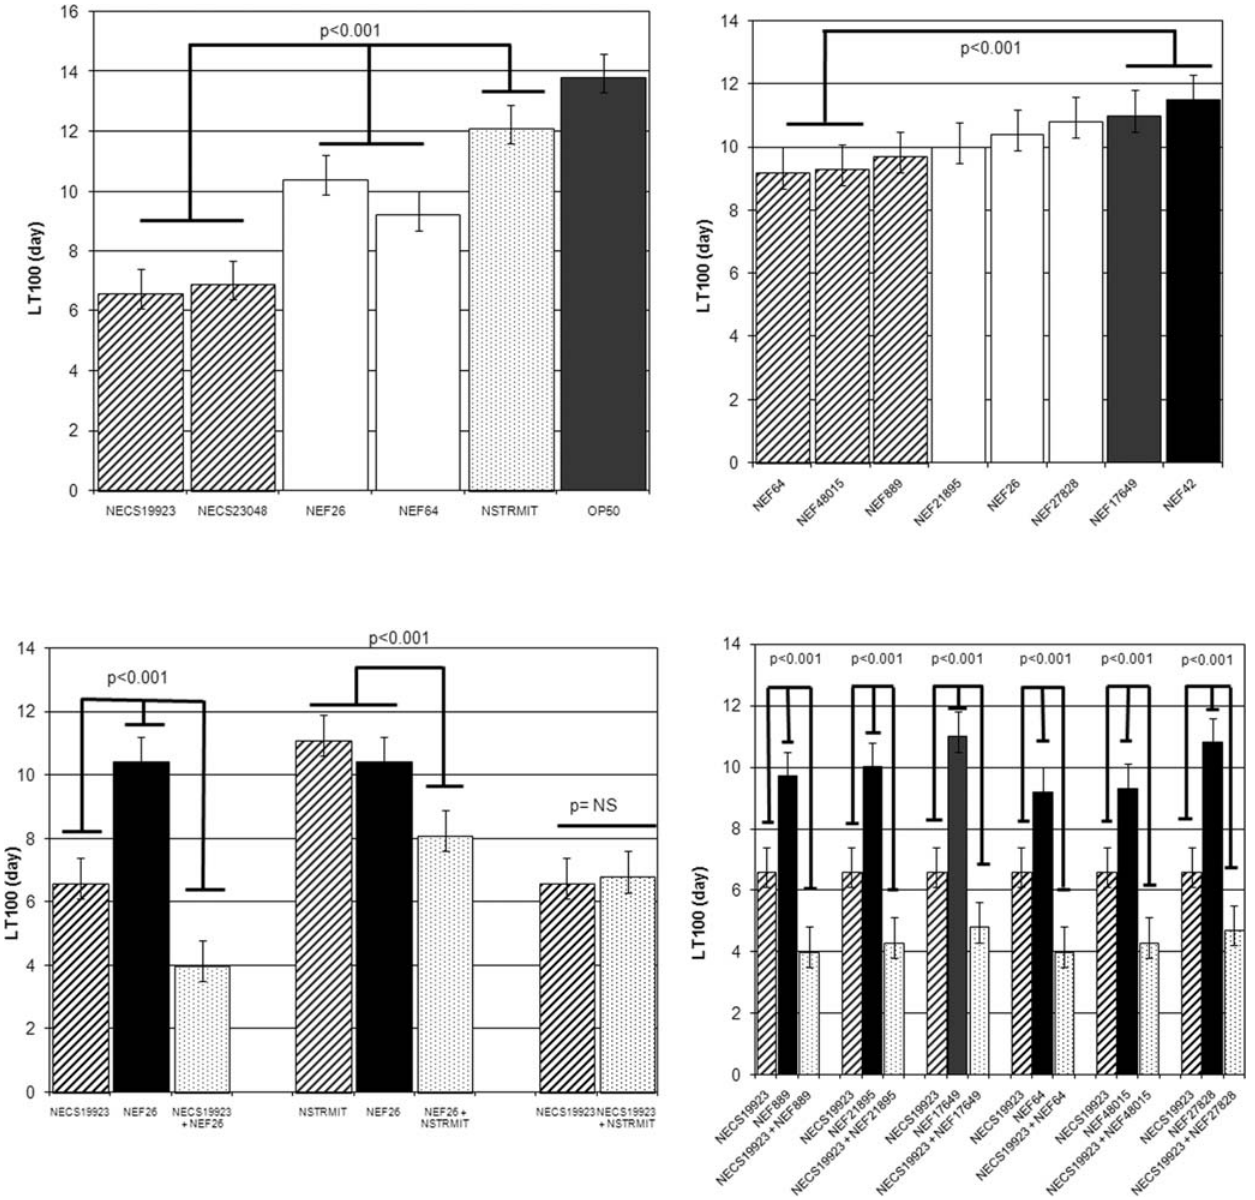
Figure 1. In vivo kinetics of killing of C.elegans infected by E.coli,E.faecalis and S.mitis strains . A. Comparison of LT100 between the different strains tested alone. B. Comparison of LT100 between E. faecalis strains tested alone. C. Comparison of LT100 with strains tested alone or in association. NEF26 was representative of the different E. faecalis strains. D. Comparison of LT100 between E. coli NECS19923 strain and the different E. faecalis strains tested in association. The results are representative of at least four independent trials for each group of strains. NS: non